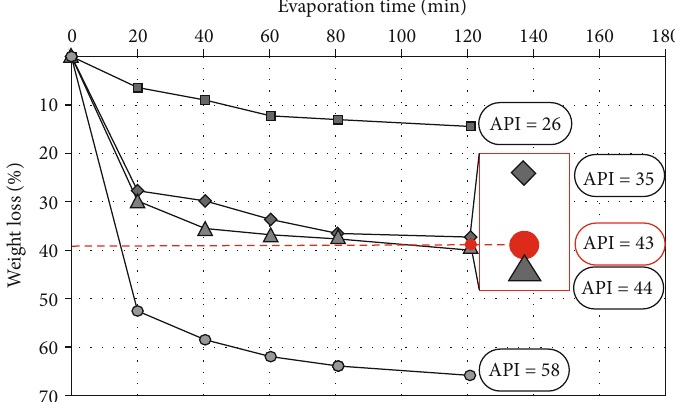
Figure 5: Loss of lighter hydrocarbons of crude oil due to evaporation process vs. oil API gravity and time — after Noble et al. 1997 [12]; in a red rectangle crude oils collected in the study area and its vicinity are presented with the average API = 43 . The assumption was made that the time of core sample handling before Rock Eval analysis exceeds 120